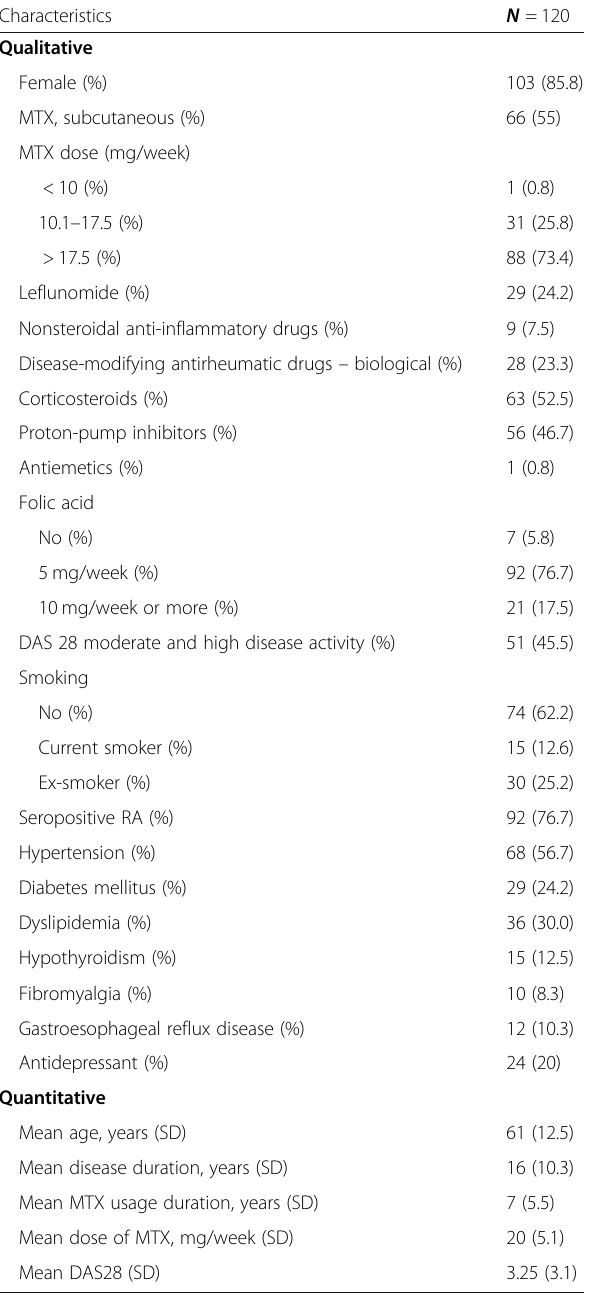
Table 1 Baseline characteristics of the patients at the time of completing the MISS